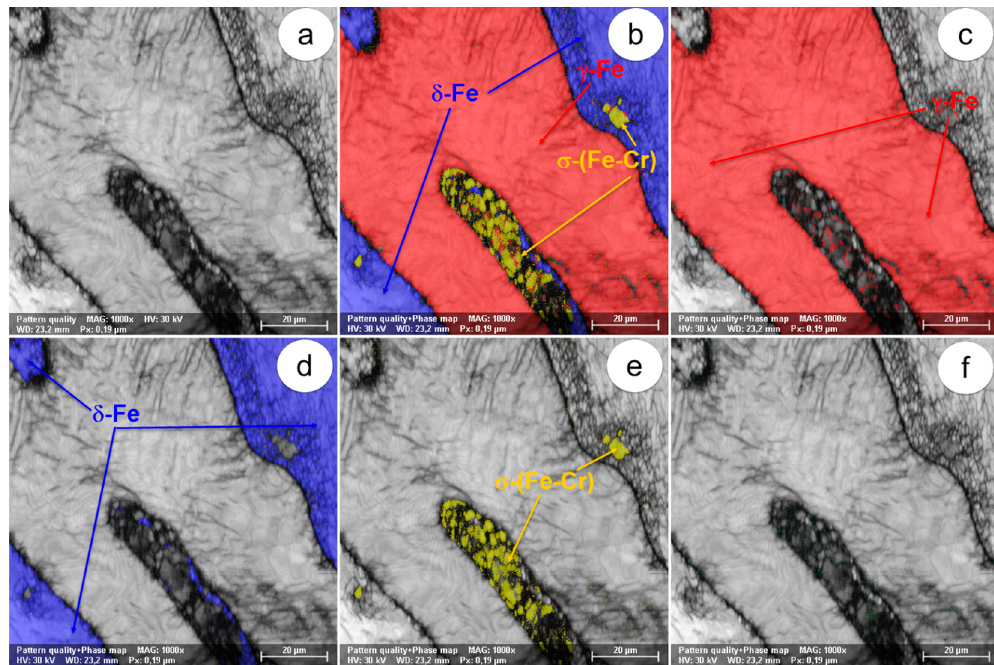
Figure 5. The SEM-EBSD composite images (×1000) obtained after forging at 800 °C: ( a ) the microstructure of the analysed field; ( b ) the distribution of the existing phases in the microstructure of the analysed field; ( c ) the distribution of the γ -Fe phase; ( d ) the distribution of the δ -Fe phase; ( e ) the distribution of the σ -(Fe-Cr) phase; ( f ) the distribution of the χ -(Fe-Cr-Mo) phase. After forging at 850 °C, the microstructure presented a more heterogeneous character compared to the previous sample forged at 800 °C, as can be seen from Figure 6 (×200) and Figure 7 (×1000).